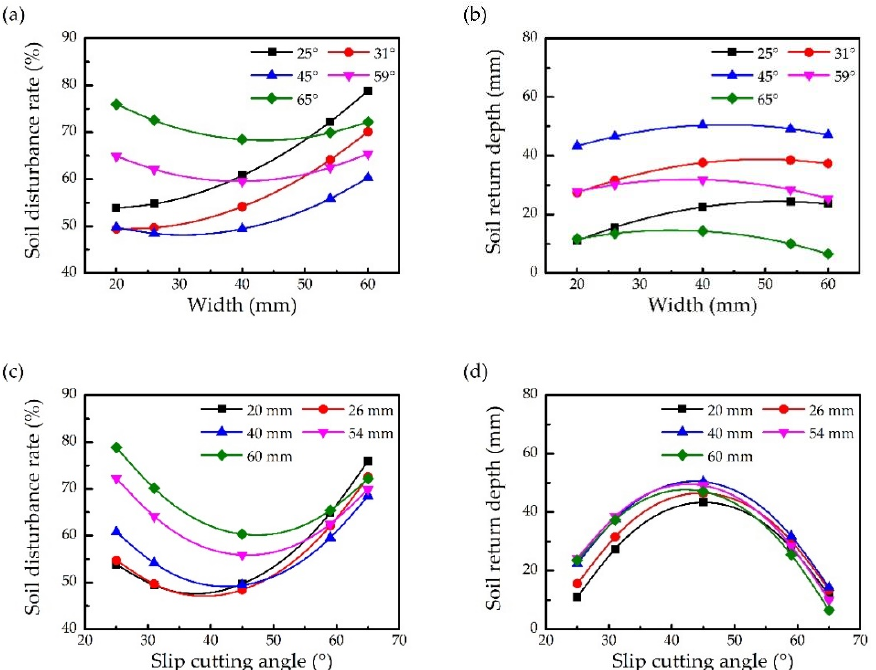
Figure 7. DEM virtual simulation test results. ( a ) The effect of the furrow opener’s width on soil disturbance rate. ( b ) The effect of the furrow opener’s width on soil-return depth. ( c ) The effect of slip cutting angle on soil disturbance rate. ( d ) The effect of the slip cutting angle on the soil-return depth. Table 2. Optimization model of test data.